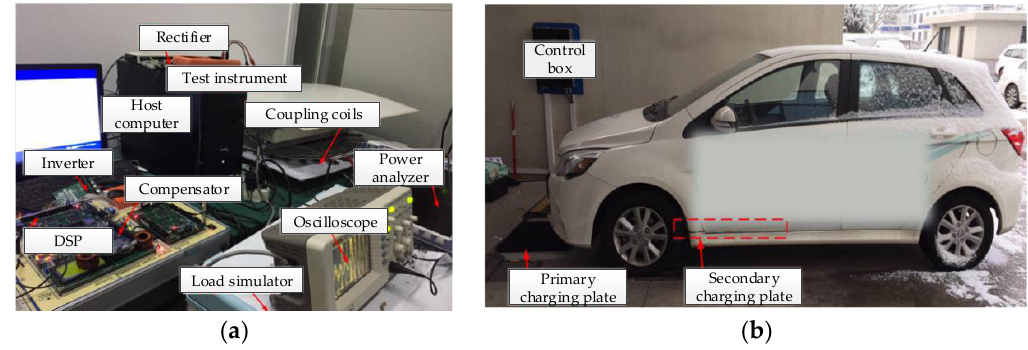
Figure 22. Experiment condition: ( a ) wireless charging test bench; ( b ) experiment vehicle.